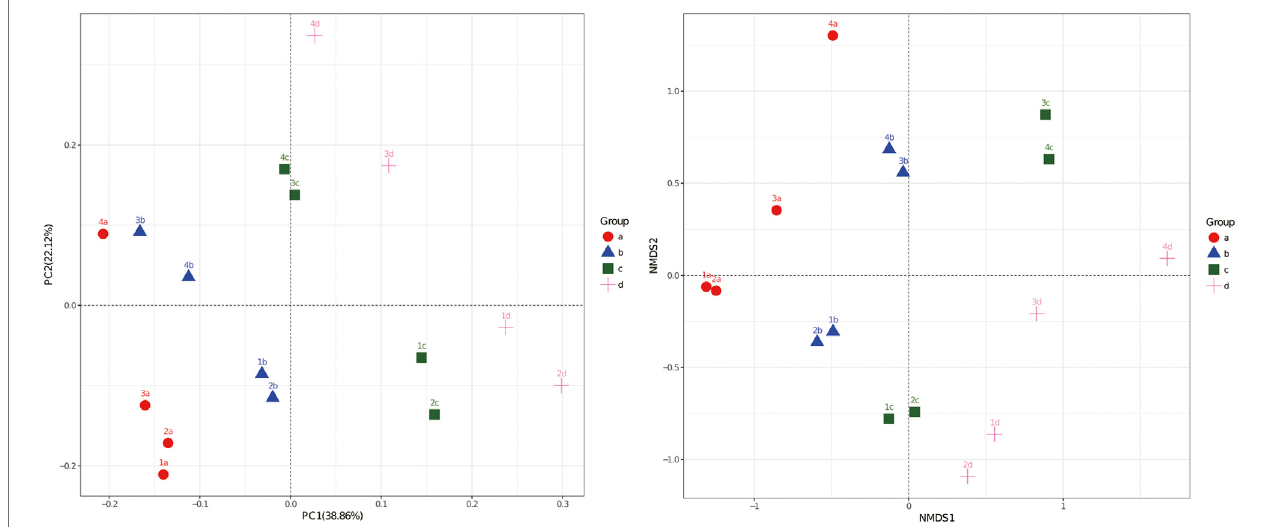
FIGURE 6 | The principal component analysis (PCA) and nonmetric multidimensional scaling (NMDS) analysis of bacterial communities based on the European distance of 16S V4 region gene sequencing for each soil sample. Letters a, b, c, and d represent 0%, 0.2%, 0.5%, and 1% NMMT added in Cd-contaminated soil,